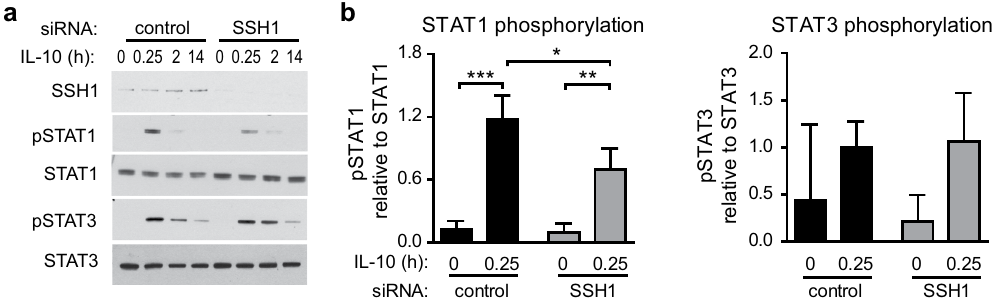
Figure 4. Depletion of SSH1 is correlated with diminished STAT1 activation. ( a/b ) Immature DCs were generated and transfected with a control siRNA or siRNA directed against SSH1. 72 hours post transfection, cells were stimulated with IL-10 (30 ng/ml) for the indicated time points and STAT activation was analysed by Western Blot. Tyrosine phosphorylation of STAT1 and STAT3 was detected by specific antibodies. To control for equal loading, total STAT protein was detected. One out of four independent experiments (a) and quantification of four experiments (b) are shown. Data represent mean and SD. For statistical analysis a one-way ANOVA with Tukey’s post hoc test was